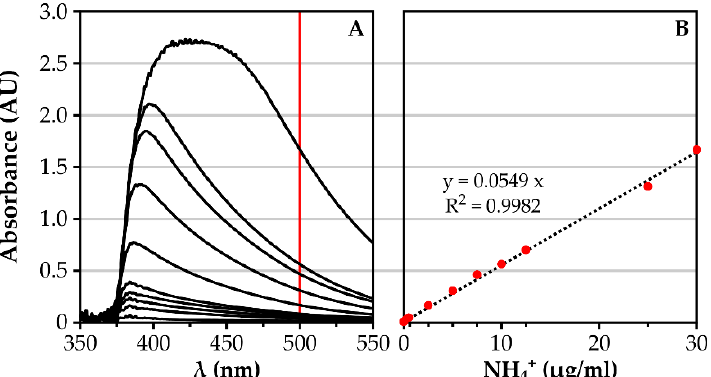
Figure 5. Calibration curve for Nessler’s ammonia detection method in water pH = 7: series of UV- vis spectra of standard solutions ( A ), curve build using reading at wavelength 500 nm ( B ).